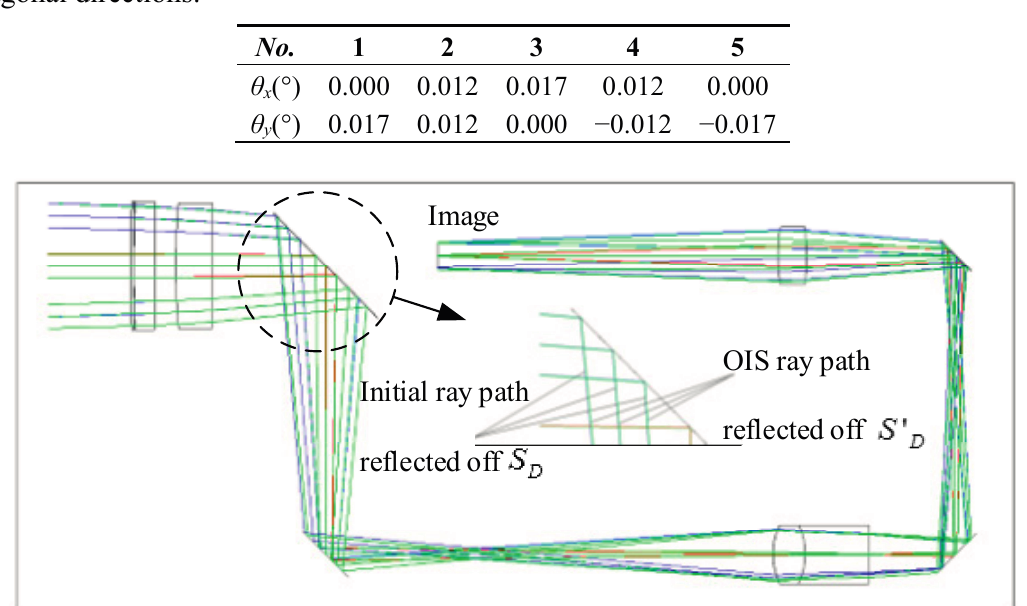
Figure 6. The overlayed drawing of the configurations for the initial ray paths using surface S D and the OIS ray paths using surface S’ D